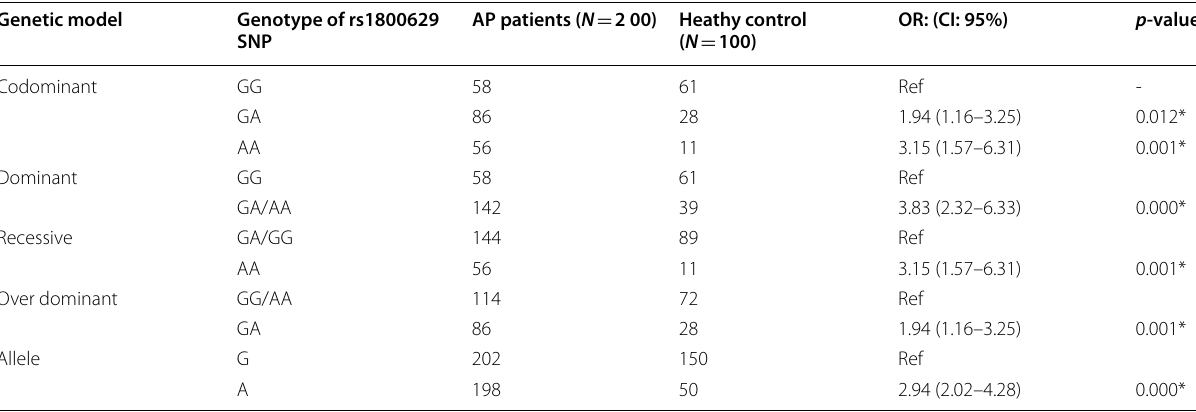
S , significant; NS , non-significant. χ 2 , chi-square distribution Table 3 Genetic inheritance model genotypes and the association for allele frequency of TNF-alpha gene polymorphism (rs1800629) 308G/Ain angina pectoris patients and control groups −